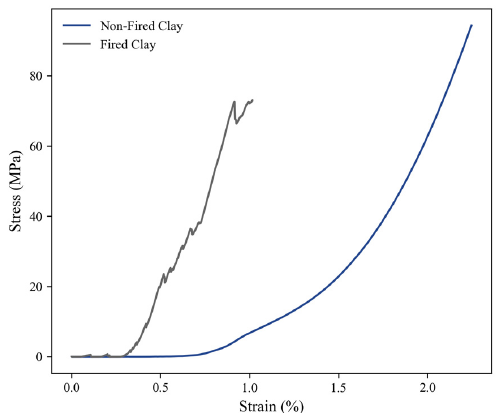
Figure 6. Stress vs. strain compression analysis of non-fired clay vs. fired clay.